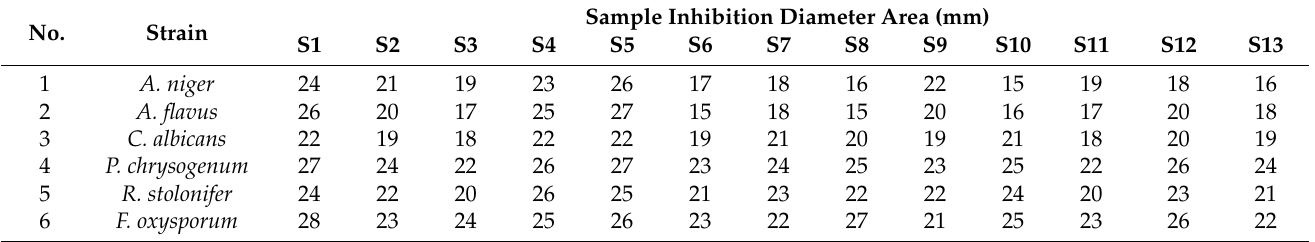
Table 9. Diameters of the inhibition zones in fungal strains for propolis aqueous extract samples from North-West and Central of Romania.